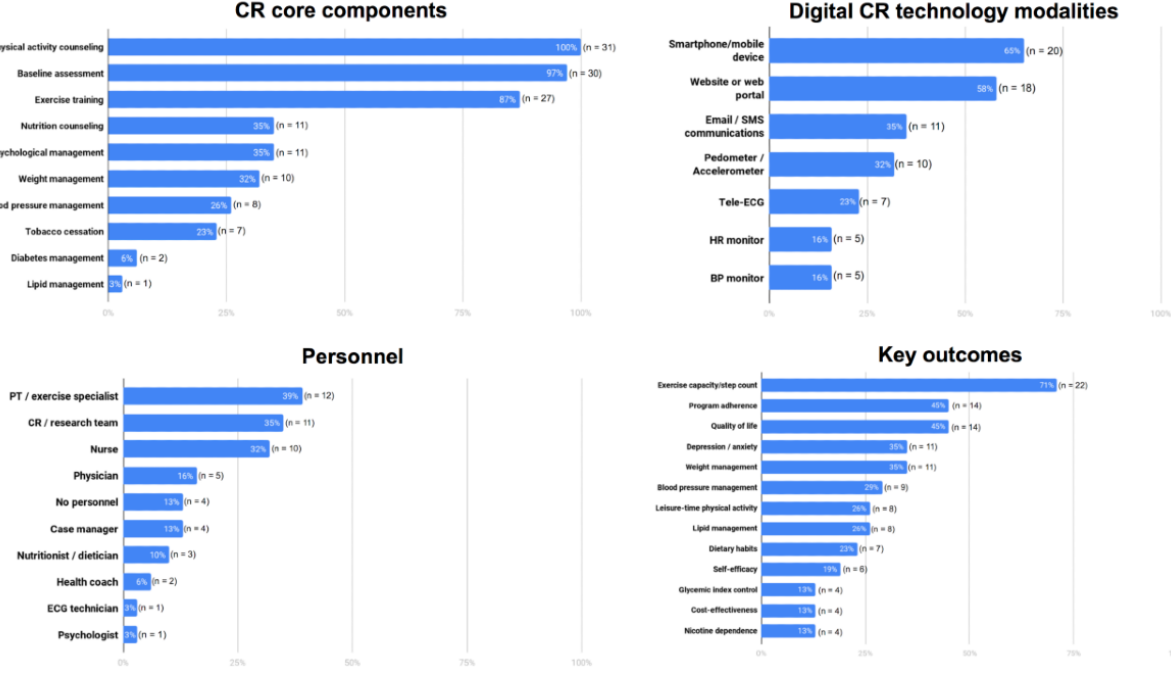
Figure 2. Percentage of studies with (1) the cardiac rehabilitation (CR) core components being addressed through digital interventions (apart from baseline assessment, which was conducted in person), (2) the technology modalities used in digital CR interventions, (3) the types of personnel employed in each CR program, and (4) the key outcomes evaluated. Cumulative percentages in some instances exceed 100% because some studies looked at multiple traits (n=31). BP: blood pressure; CR: cardiac rehabilitation; ECG: electrocardiogram; HR: heart rate; PT: physical